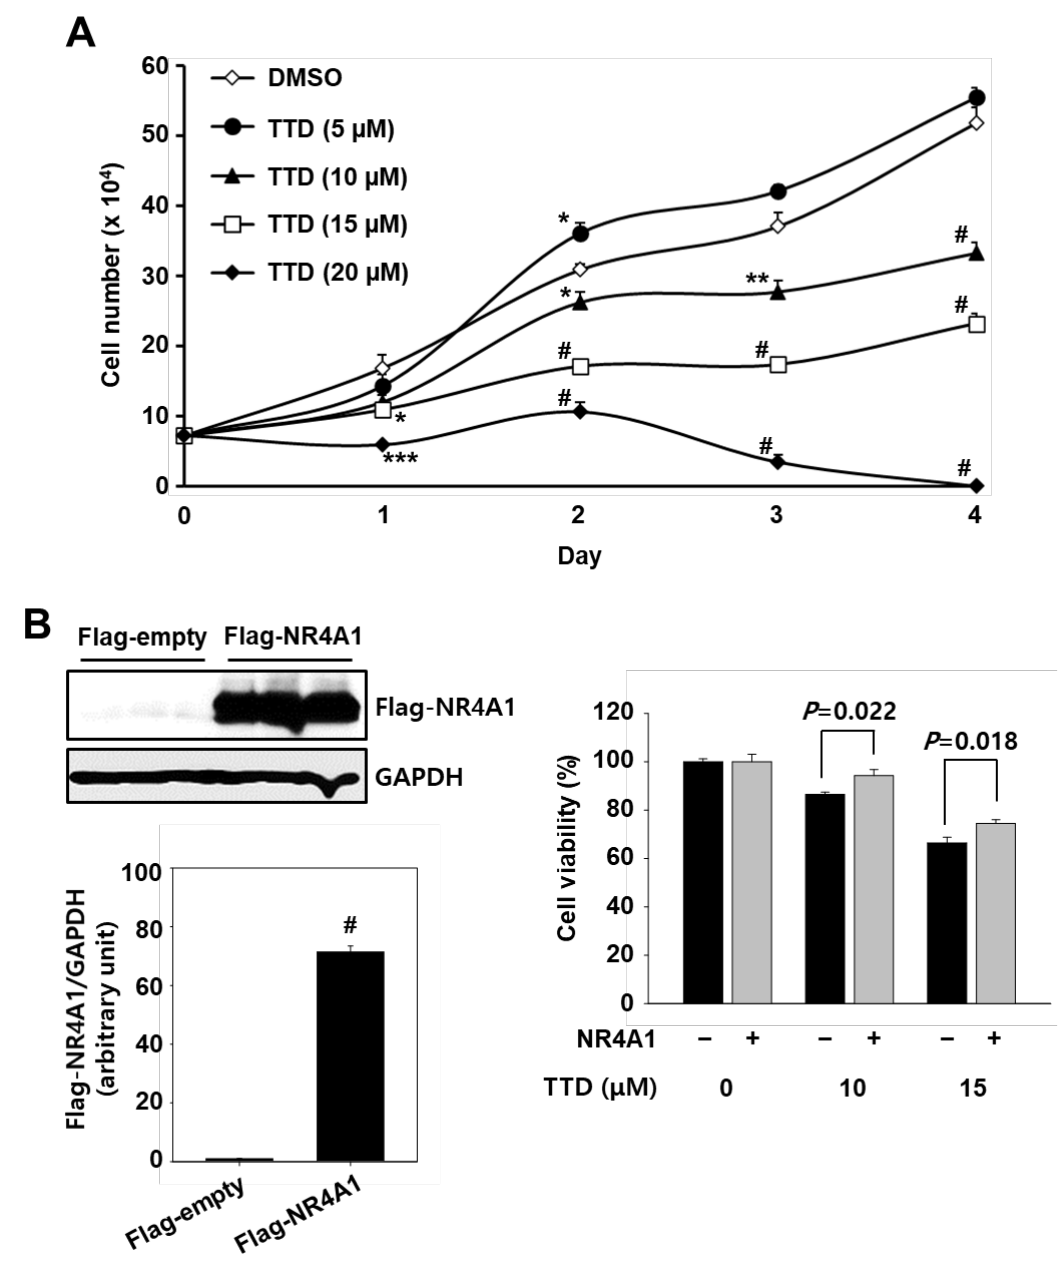
Figure 3. TTD inhibits cell proliferation in pancreatic cancer cells. ( A ) Panc-1 cells were treated with various concentrations of TTD for the indicated time. ( B ) NR4A1-mediated cell growth inhibition by TTD. Cells were transfected with either Flag-empty or Flag-NR4A1 for 6 h and at 24 h after transfection, cells were treated with TTD for 24 h. Whole cell lysates were analyzed by western blot analysis. GAPDH was used as a loading control. Cell viability was determined as described in the Materials and Methods section. The results are presented as means ± SEM ( n ≥ three replicates). * p < 0.05, ** p < 0.01, *** p < 0.005 and # p < 0.001 vs. DMSO or Flag-empty.